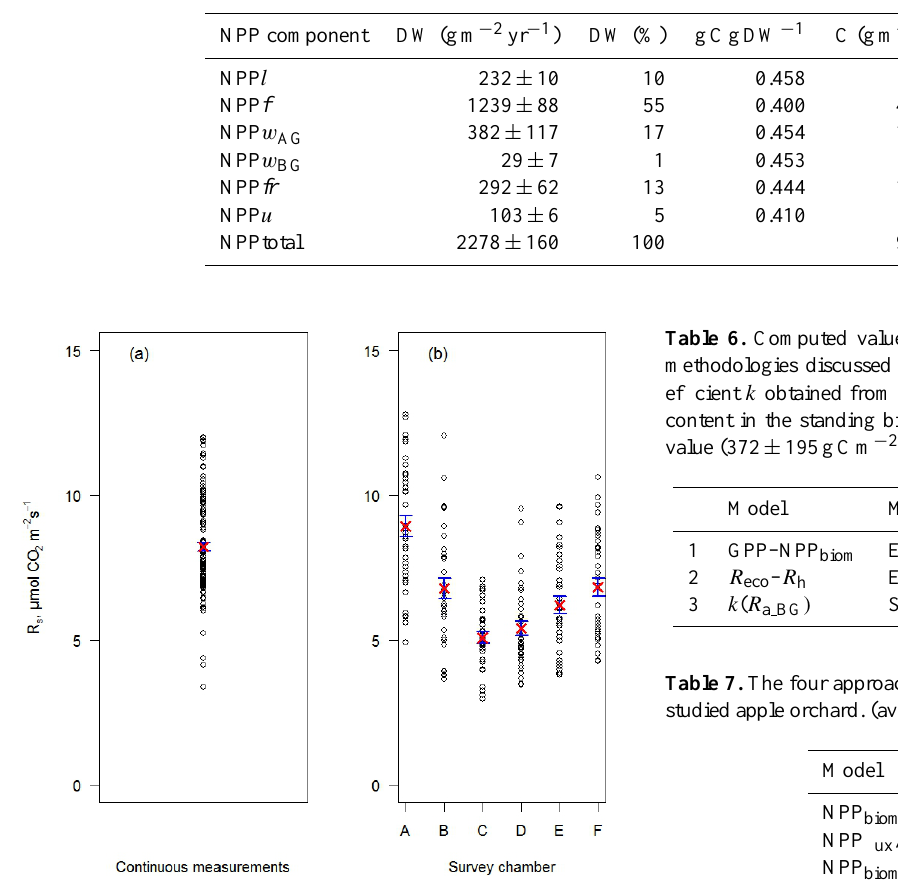
Table 5. Yearly NPP values of the ecosystem components measured biometrically (data are expressed in gDWm − 2 yr − 1 and gCm − 2 yr − 1 ± standard error of the mean).